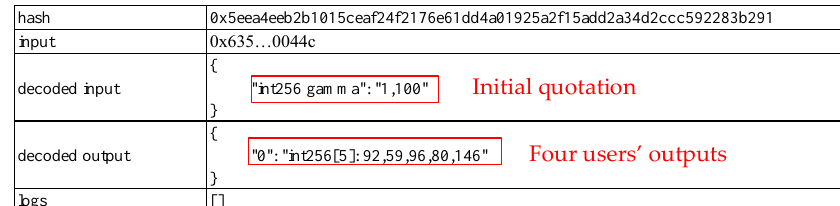
Figure 3. Input of the buy ers’ characteristic parameters.